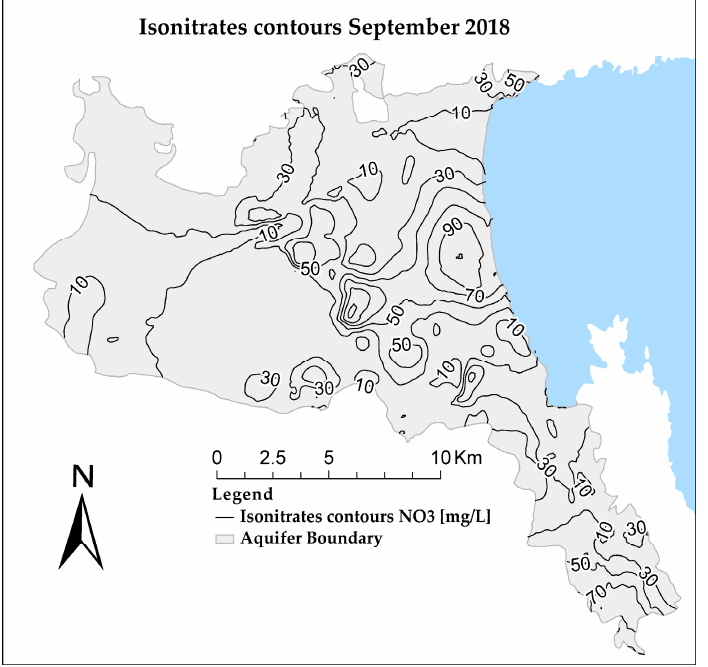
Figure 20. Isonitrates contours at the end of the simulation of nitrate pollution in September 2018.